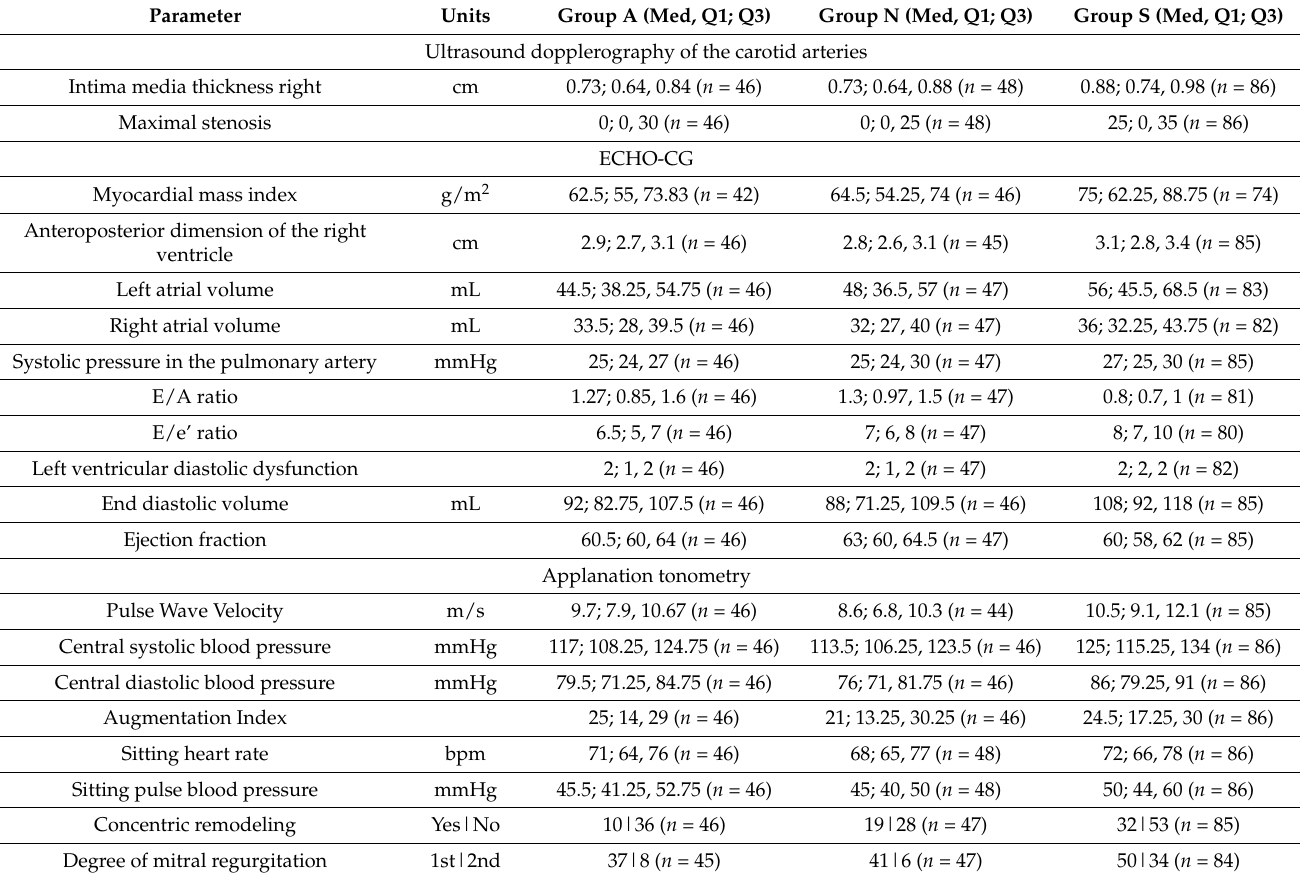
Table 1. Group-wise statistics for the cardiovascular